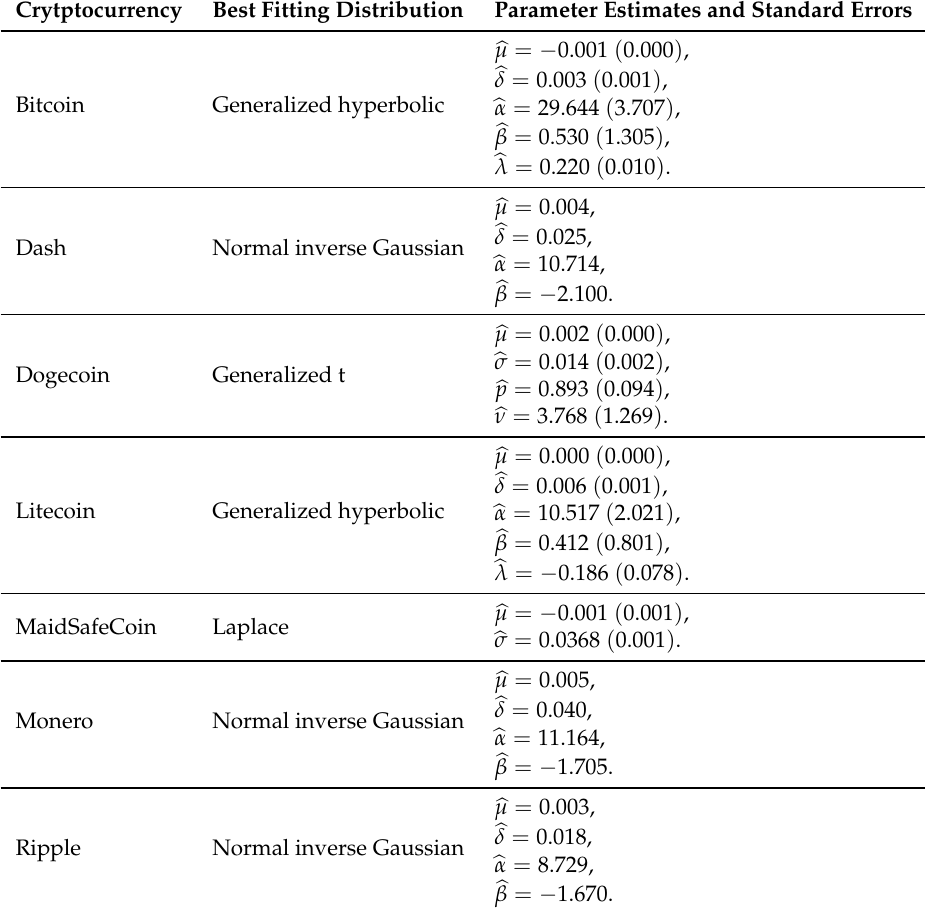
Table 3. Best fitting distributions and parameter estimates, with standard errors given in